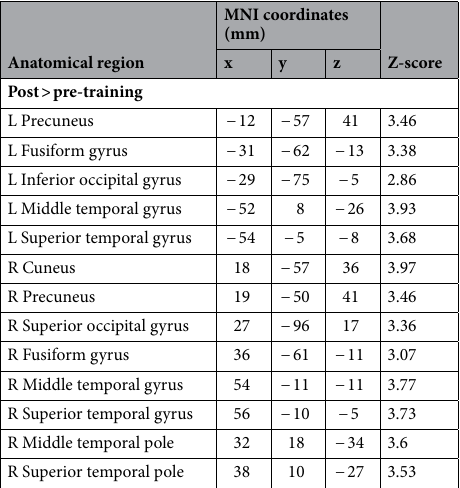
Table 3. MNI coordinates of the local maxima of regions activated during motor imagery of the dart throwing task across all participants (only coordinates from peak voxel are shown). Comparisons were conducted to assess differences in motor imagery-related brain activation following training. No significant differences in activation were observed for pre >